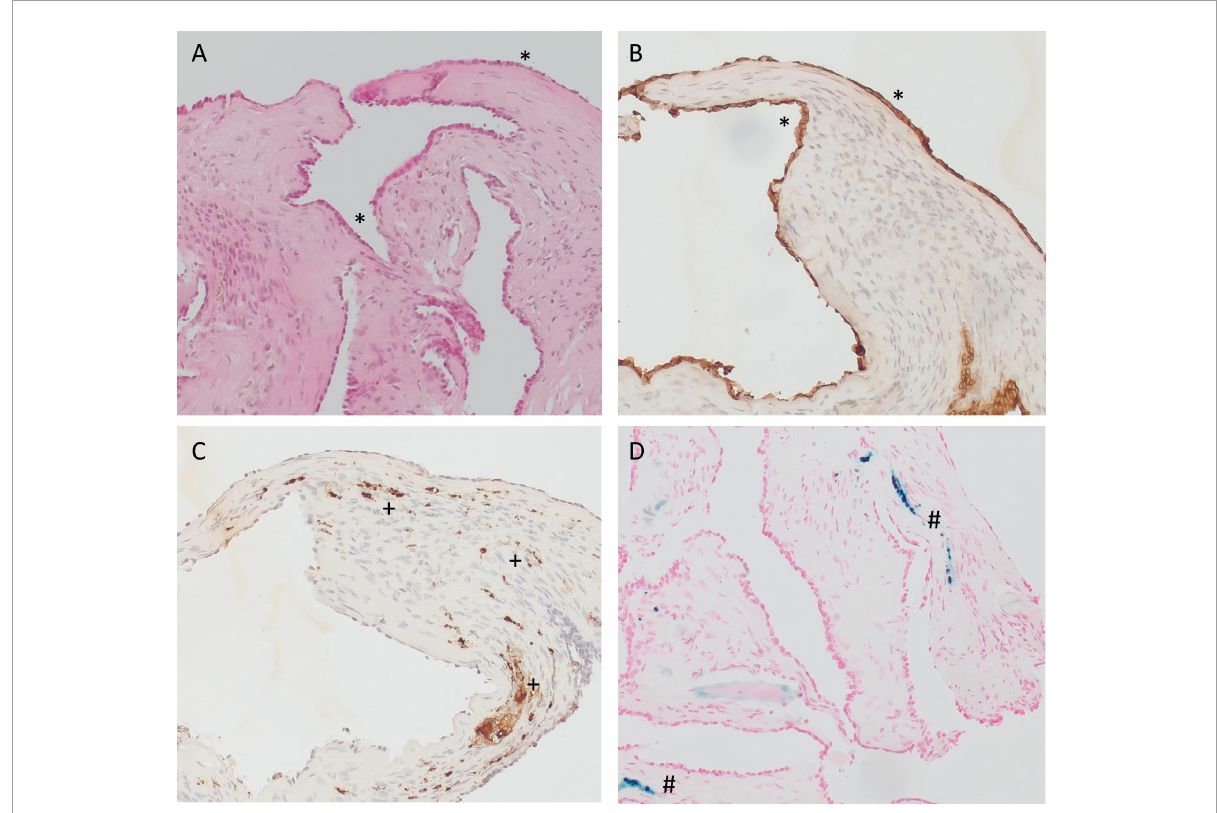
FIGURE7 Immunohistochemistry of specimens taken from the RW area at the time cochlear implantation. (A–C) 16 months and (D) 6 months after implantation of the biodegradable drug delivery system and sealing with soft tissue. (A) hematoxylin-eosin (H&E), 100x; (B) PanCKplus, 100x; (C) CD68, 100x; (D) Prussian blue, 100x. (Immuno-)histochemistry confirmed that the surface cover ( ∗ ) was a true epithelium (PanCKplus positive), (A,B) . Within the stroma, we found scattered CD68-positive macrophages (+) as a sign of chronic resorptive inflammation (C) and/or tissue reactivity to Prussian blue (#) as a sign of blood residua (D) . (A – C) Same patient as in Figure 6B ; (D) same patient as in Figure 6C .